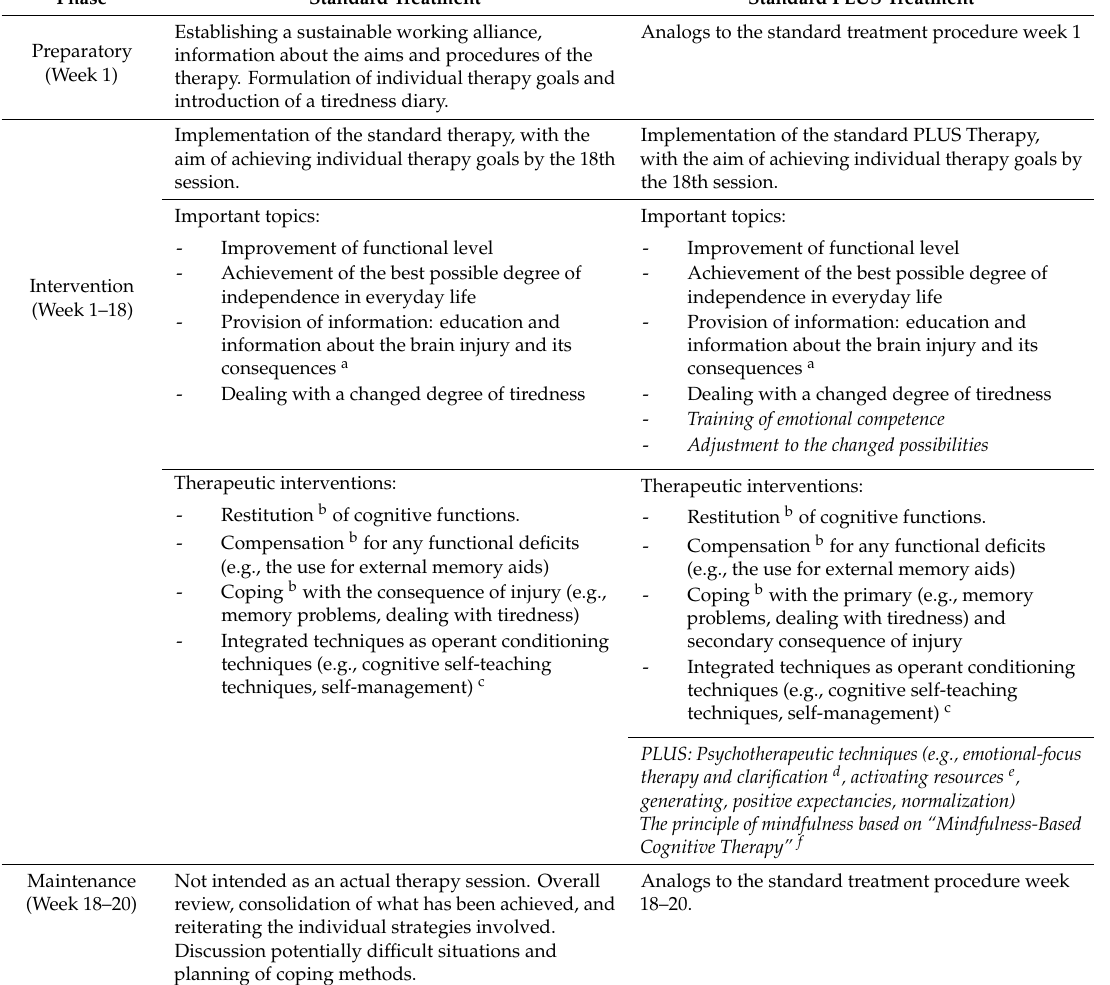
Table 1. Overview of the